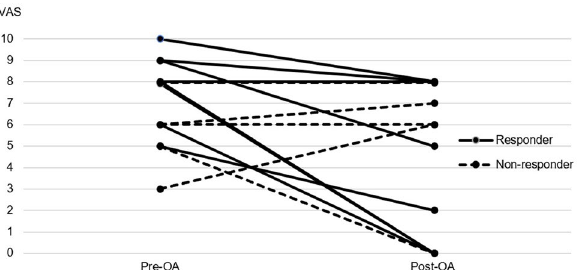
Figure 2. Change in severest headache intensity for each individual subject of the headache responder and non-responder groups. VAS visual analog scale (0 is no pain and 10 is the worst imaginable pain possible). OA oral appliance. Microsoft PowerPoint 2019 (Microsoft, Redmond, WA, USA) https ://www.micro soft.com/en-ca/ micro soft-365/power point